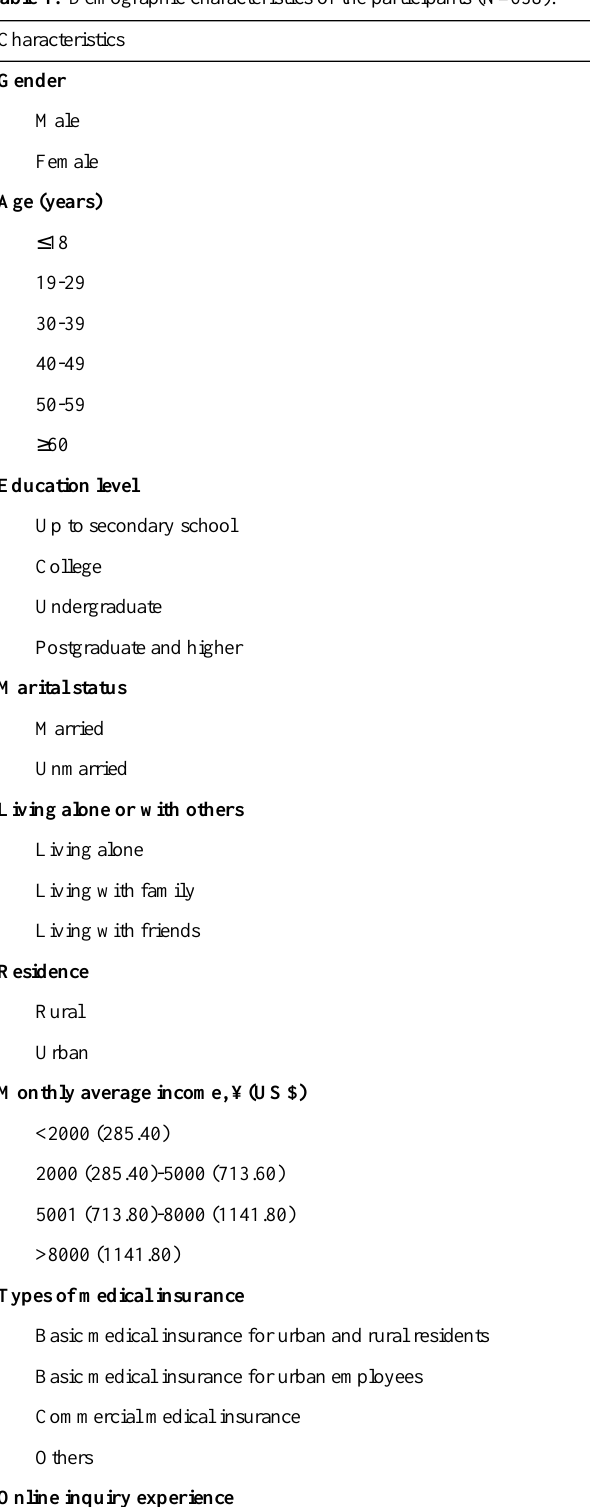
Table 1. Demographic characteristics of the participants